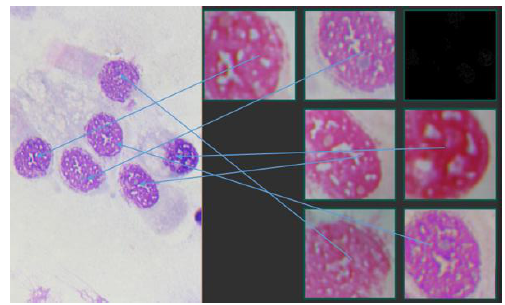
Figure 9. Original image ( left ) and extracted cells ( right ).